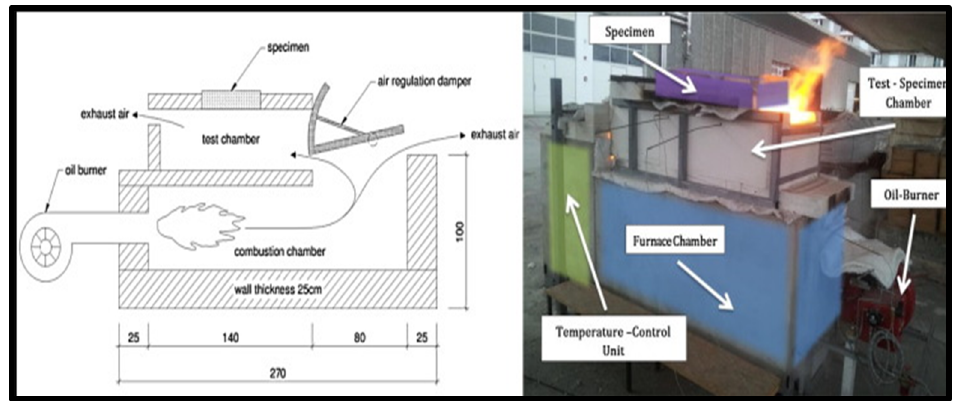
Figure 17. Two ‐ chamber fire furnace (dimensions in